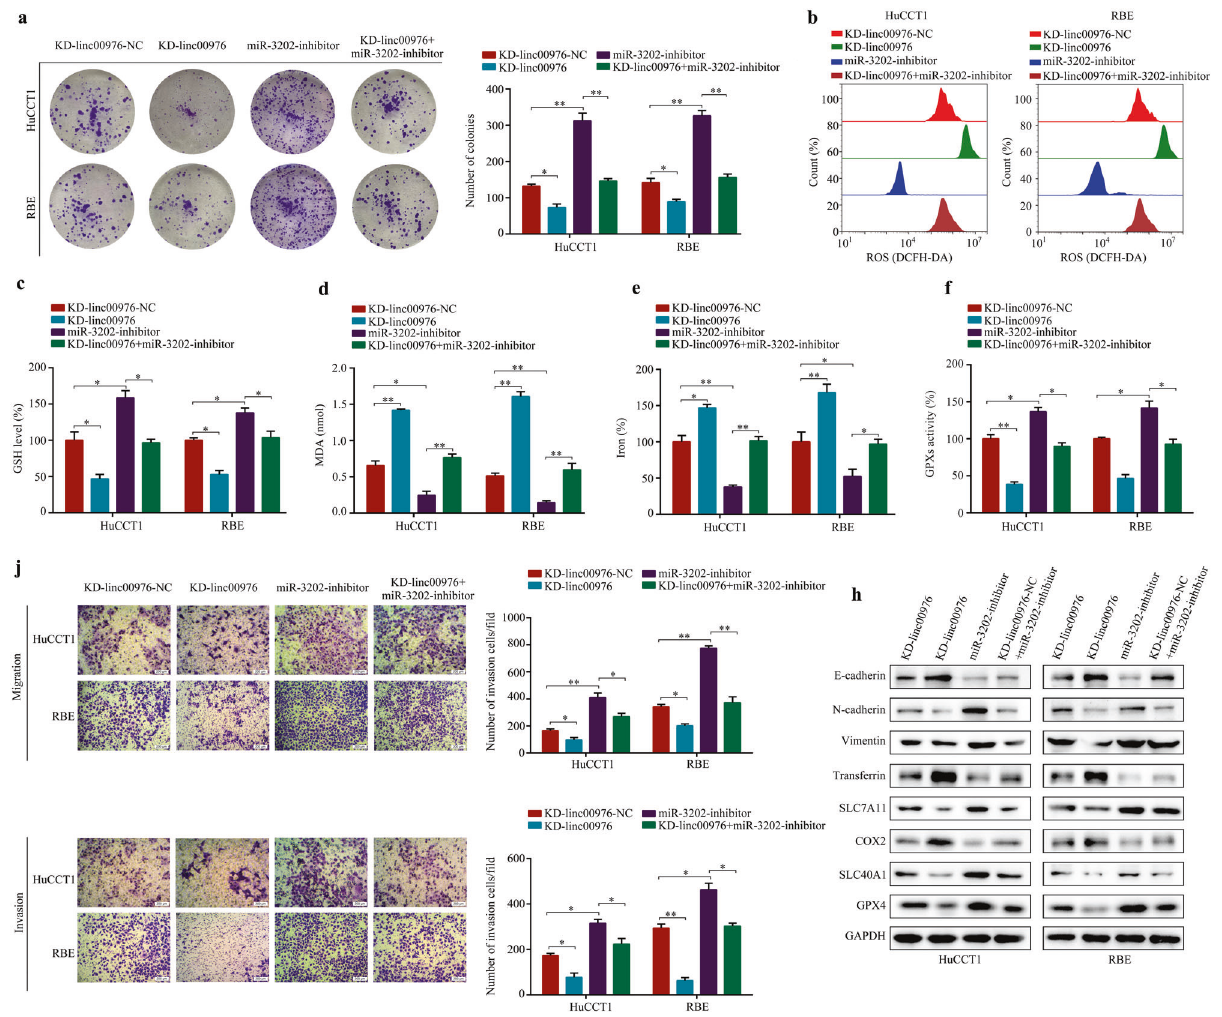
Fig. 5 Knockdown of miR-3202 rescues KD-linc00976-mediated inhibitory effect on the proliferation, metastasis, and ferroptosis in CCA cells. a CCA cells were transfected with KD-linc00976-NC or KD-linc00976 or co-transfected with KD-linc00976 and miR-3202 inhibitors. Colony formation assays detected the cell proliferation ability of CCA cells in each group. b – f Effects of miR-3202 silencing on KD-linc00976-mediated ROS, GSH, MDA, iron progression, and GPX activities in CCA cells. j Transwell migration and Matrigel invasion assays evaluated the effect of miR-3202 silencing on KD-linc00976-mediated migration and invasion ability. Scale bar, 50 μ m. h The protein expressions of ferroptosis and EMT-associated biomarkers were analyzed by western blotting and normalized to GAPDH. * P < 0.05, ** P < 0.01. CCA